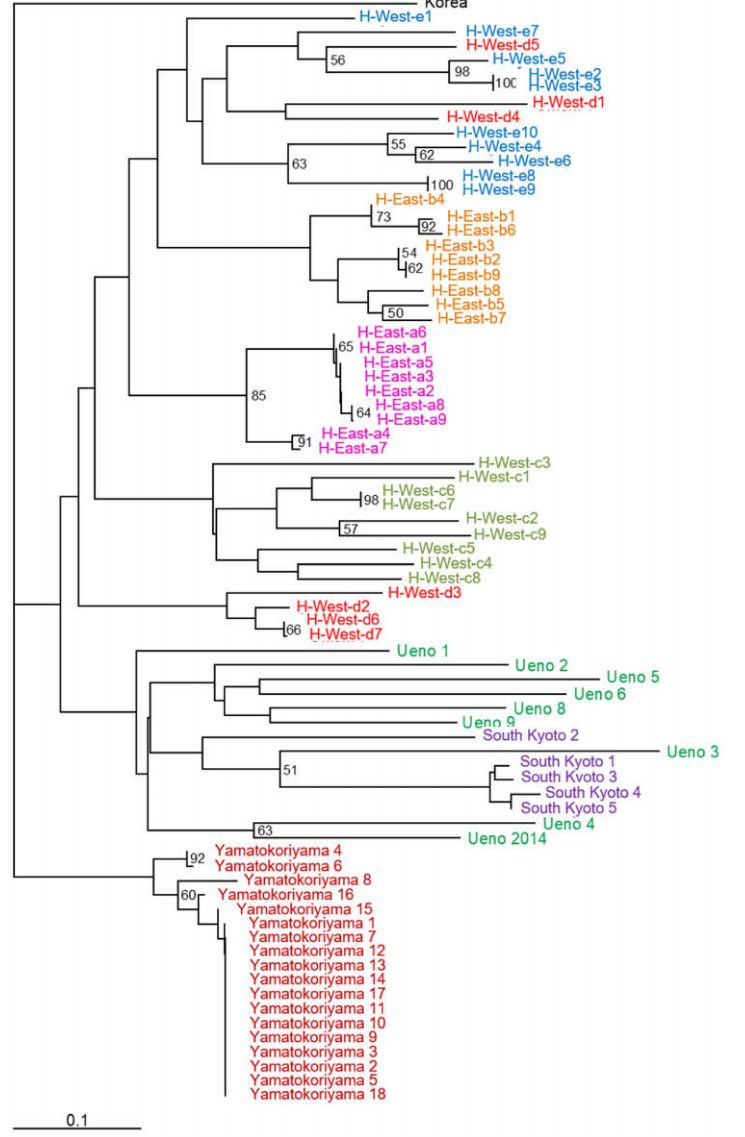
Figure 3. Neighbor-joining phylogenetic tree of H. radiata collected from the Kinki area. Numbers at the nodes are bootstrap values from 1000 replications (>50%). Scale bar: genetic distance